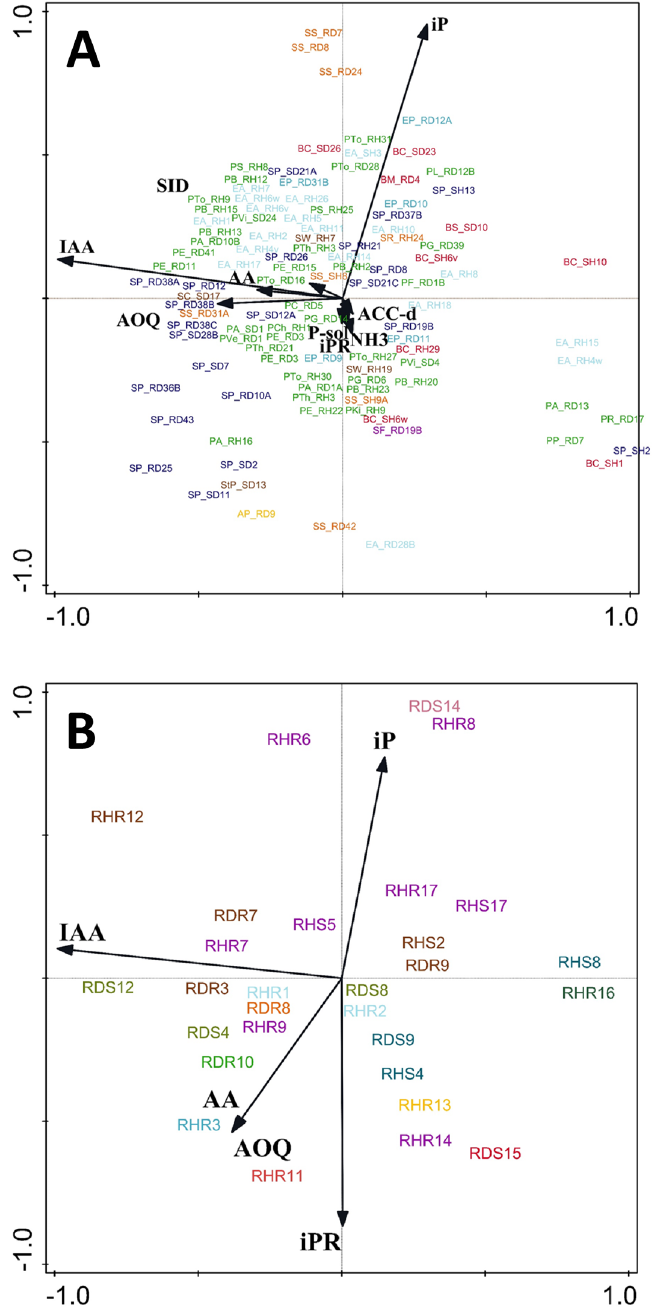
Figure 4. Ordination PCA diagram of bacterial (A) and fungal (B) isolates. First two axes explained 66% (A) and 79% (B) variation. Colours indicate taxonomic grouping (See Table S1 and S2). The two characters behind the underscore (bacteria) or initial letter “R” (fungi) in the isolates code are related to the origin of the isolate: R, root; S, shoot/stem; H, healthy = without Phoma stem canker symptoms; D, diseased = with symptoms of Phoma stem